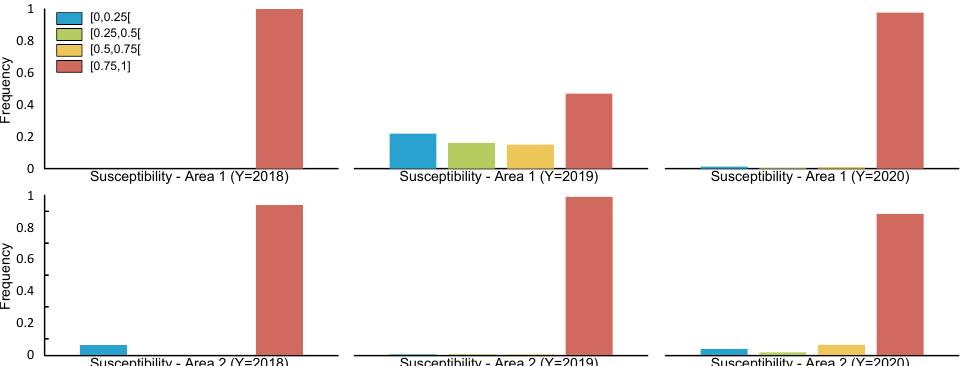
Figure 12. Observed susceptibility values w.r.t. the fire-affected areas in the reference dataset for each study area and epoch with OC-SVM method as anomaly detection